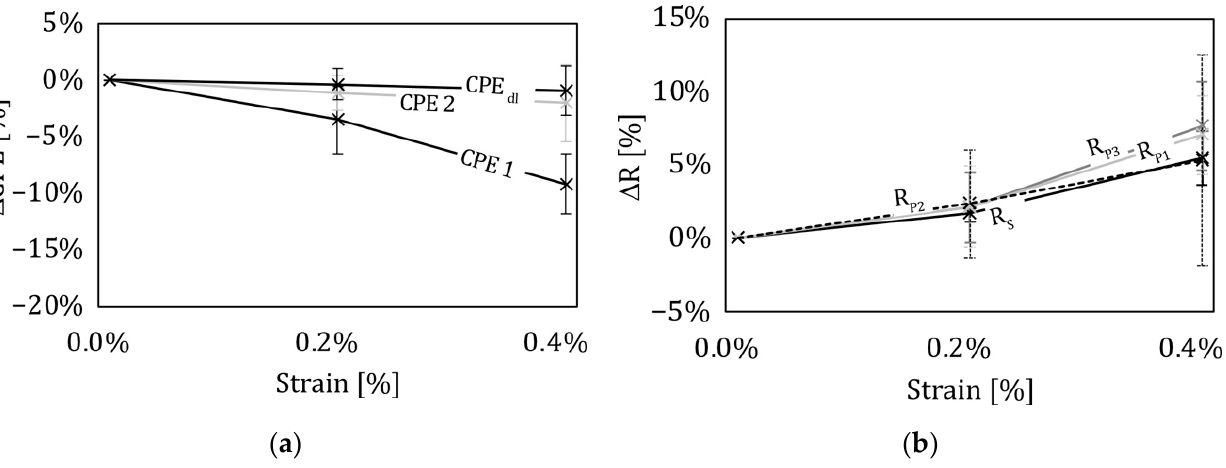
Figure 8. Fitting results of the electrochemical equivalent circuit due to mechanical load in a four- point bending experiment. The figures show the mean of each element based on six samples. Error bars indicate the standard error. ( a ) Change of the constant phase elements through mechanical load. ( b ) Change of the charge transfer through mechanical load.